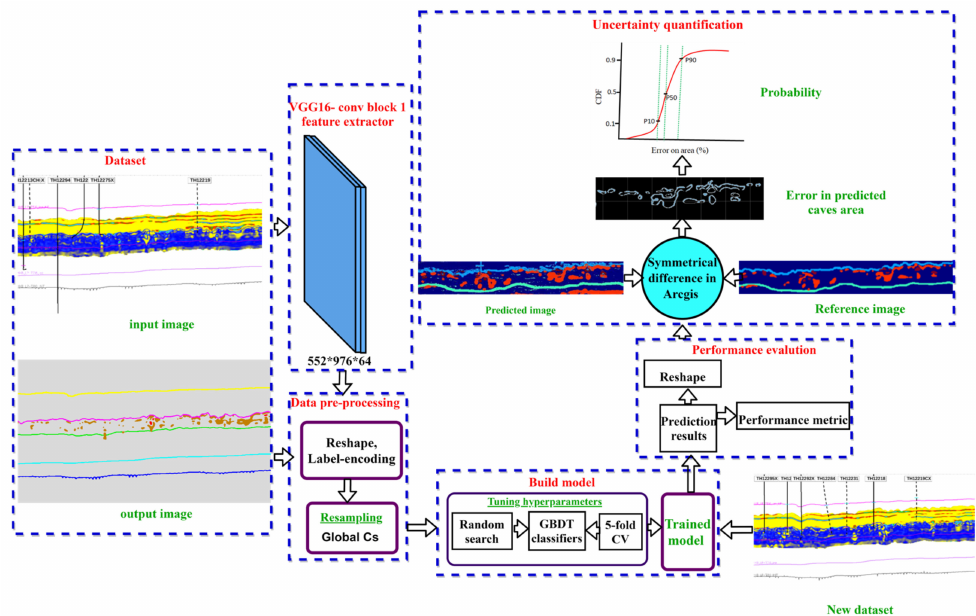
Figure 5. Study workflow.